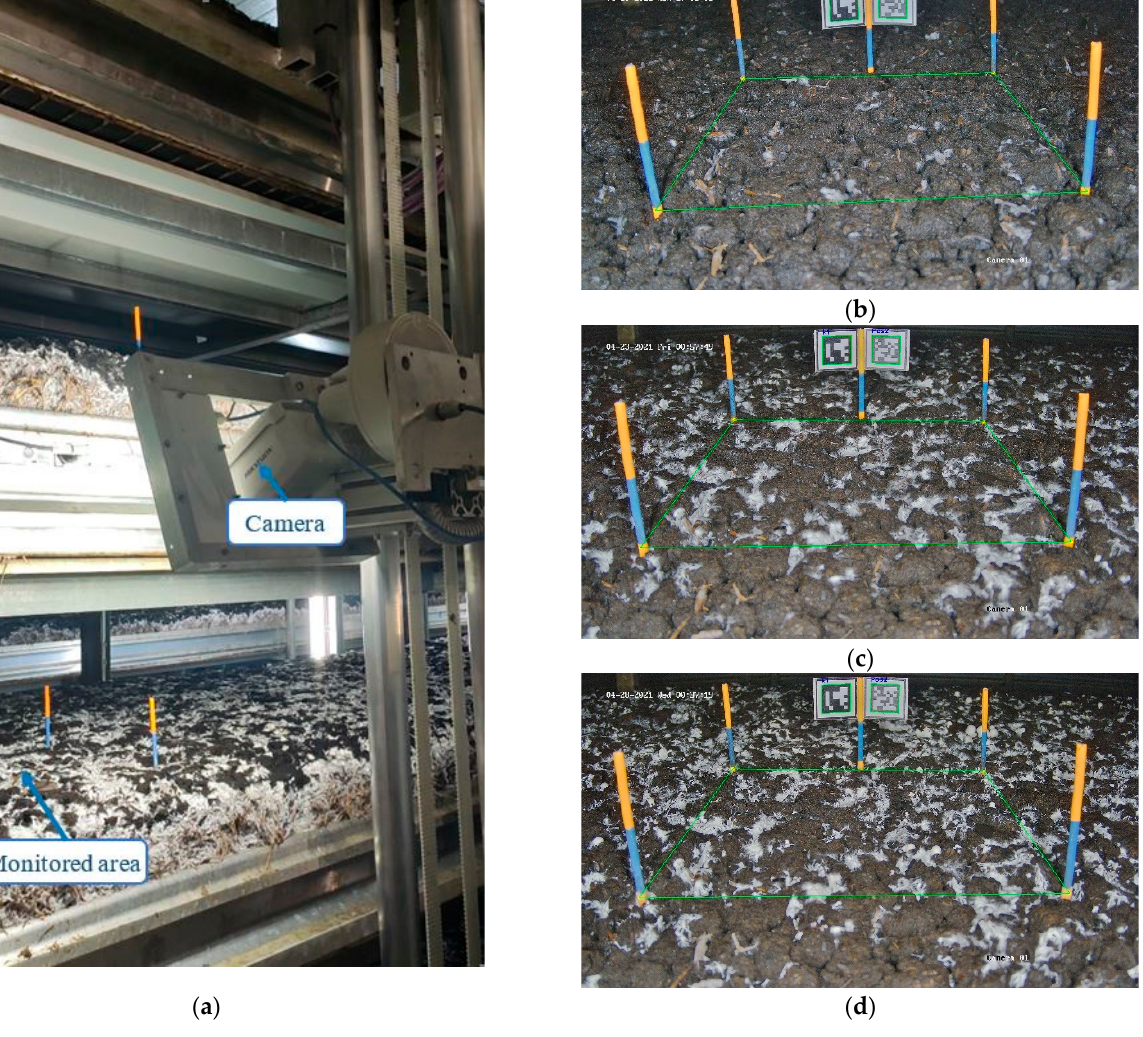
Figure 3. System for visual monitoring ( a ) in the mushroom growing hall, examples of calibrated images taken on the 6th ( b ), 10th ( c ) and 15th ( d ) days of cultivation process.